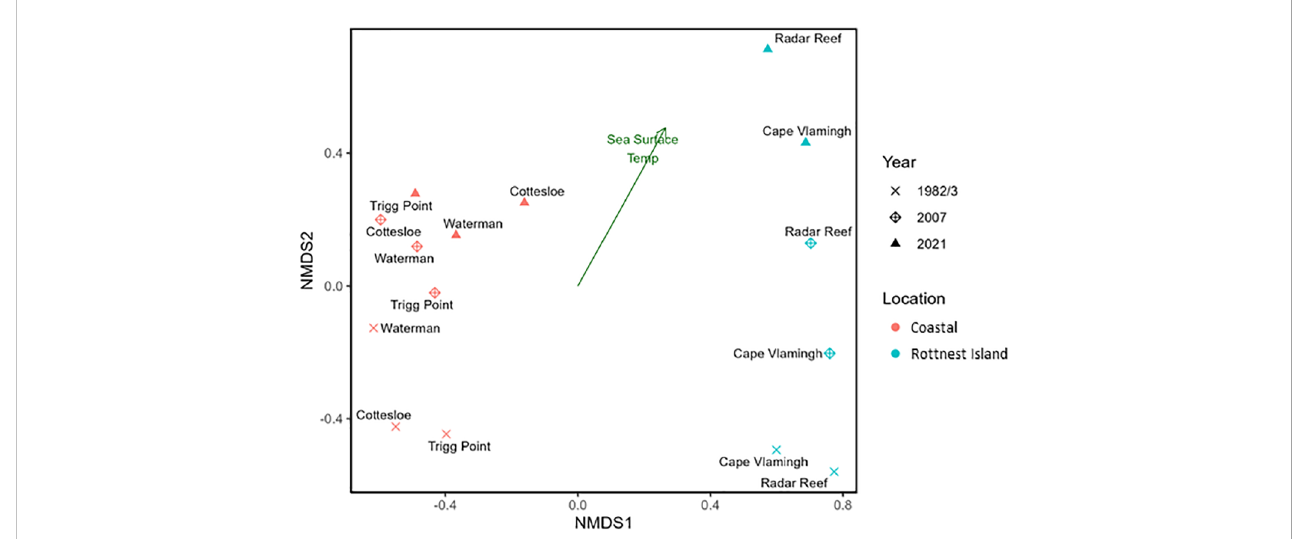
FIGURE 4 nMDS plot of mollusc assemblages in 1982/3, 2007 and 2021 for Perth coastal platforms and Rottnest Island sites.